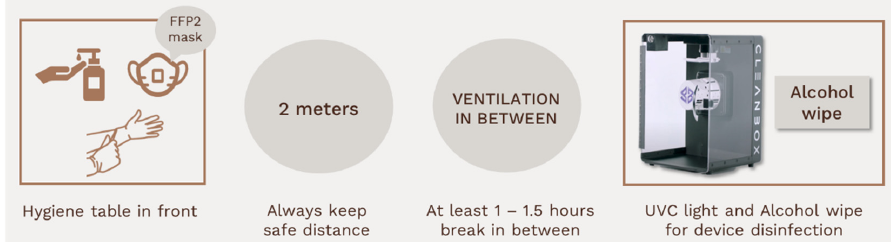
Figure 17. On-site safety measures for organizing user test during the pandemic.